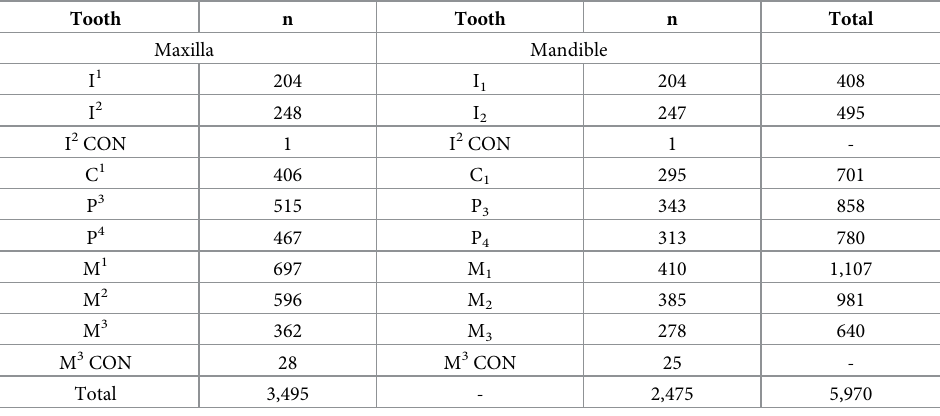
Table 2. Tooth counts of the right side of the maxillary and mandibular dental arcades. Tooth n Tooth